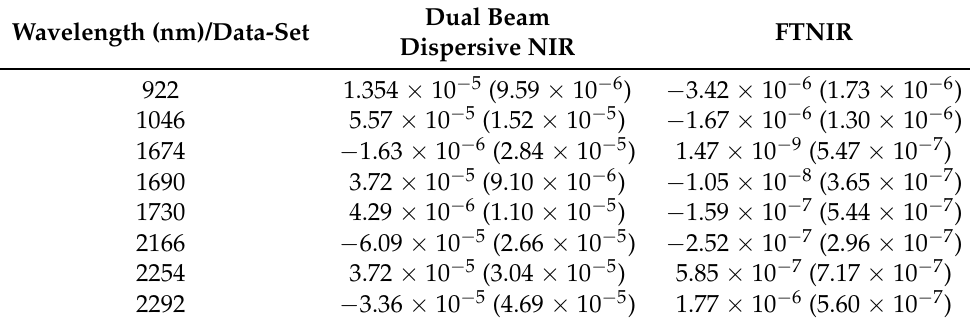
Table 4. Linear Regression on wavelengths pertinent to lactate in both the data-sets. Wavelength